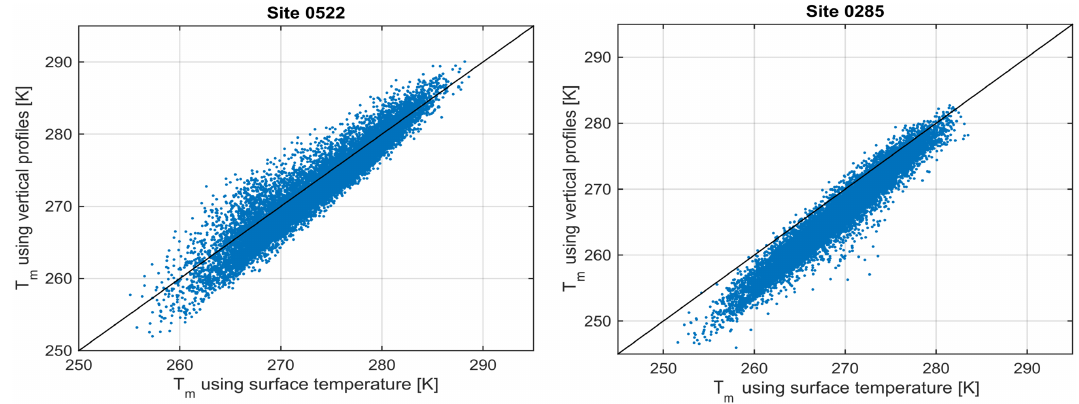
Figure 4. Mean atmospheric temperature, T m , determined once using surface temperature and vertical atmospheric profiles from ERA- Interim at the sites 0522 (399ma.m.s.l.) and 0285 (1779ma.m.s.l.). The bias is 0.97K for the first site and 3.02 for the second, and the SD is 2K for the first and for the second